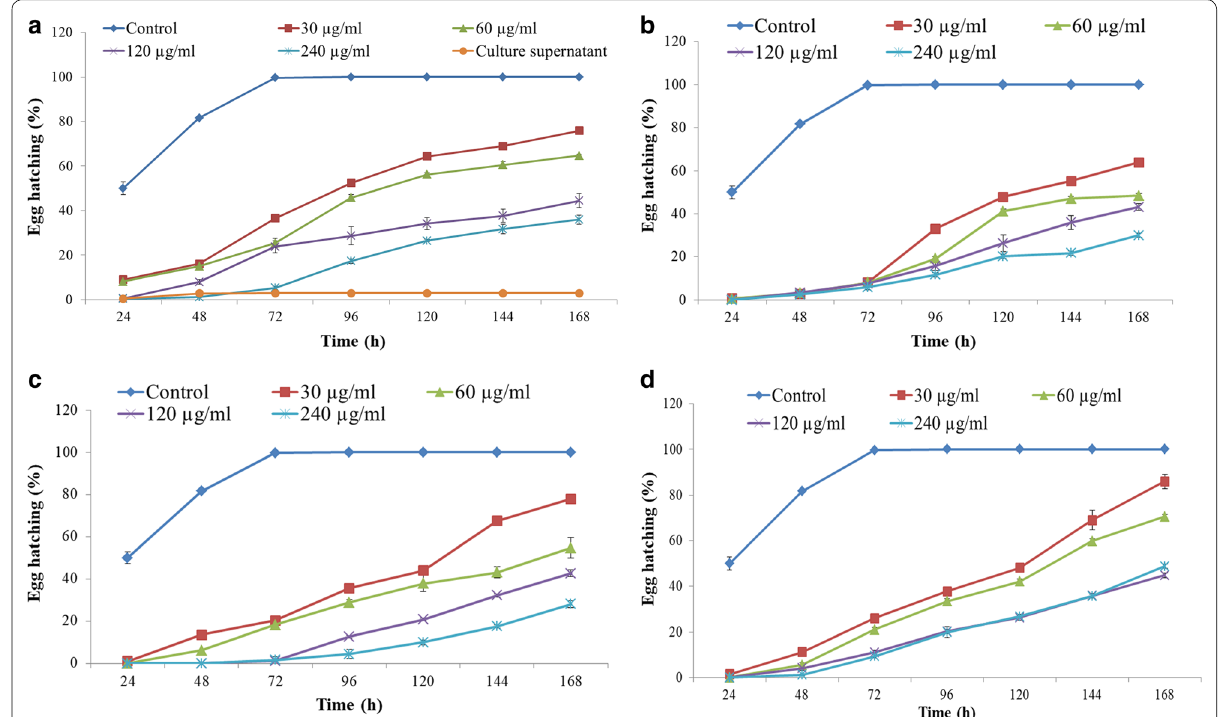
Fig. 2 Egg hatching inhibition in M. incognita treated with S. antibioticus strain M7 metabolites: a EtOAc extract and culture supernatant, b actinomycin V, c actinomycin X 2 , d actinomycin